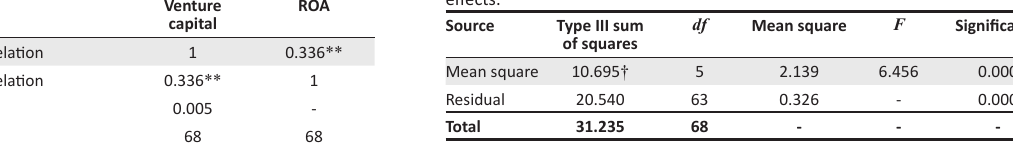
TABLE 3: The Pearson’s correlation test for venture capital financing and ROA.